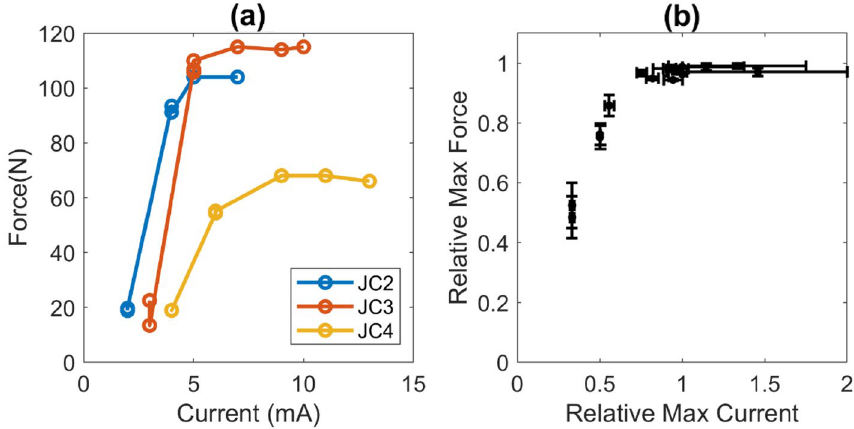
Figure 15. Recruitment curve. ( a ) Twitch force versus stimulation current for one subject. ( b ) Recruitment curved calculated for 12 subjects. Active force and stimulation current were normalized to their respective maximum value at each joint configuration during the CMAP probing trials described by step 20 above.